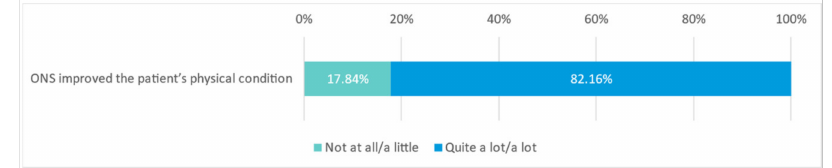
Figure 7. Improvement in the patients’ physical condition by ONS (N = 863 physicians).